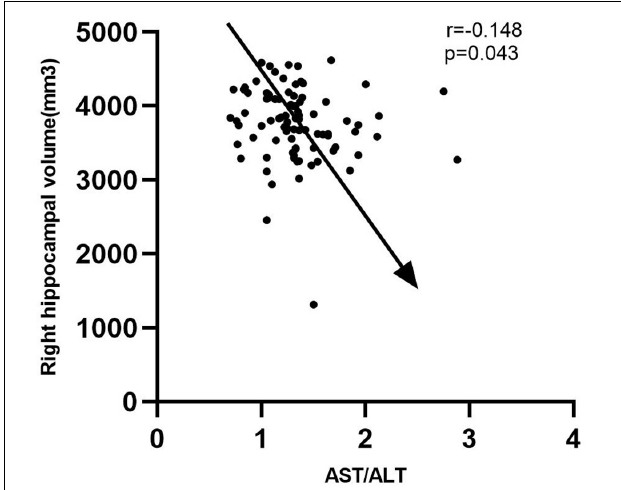
FIGURE 5 | Correlation between AST/ALT ratio and right hippocampus volume. AST, aspartate aminotransferase; ALT, Alanine aminotransferase.